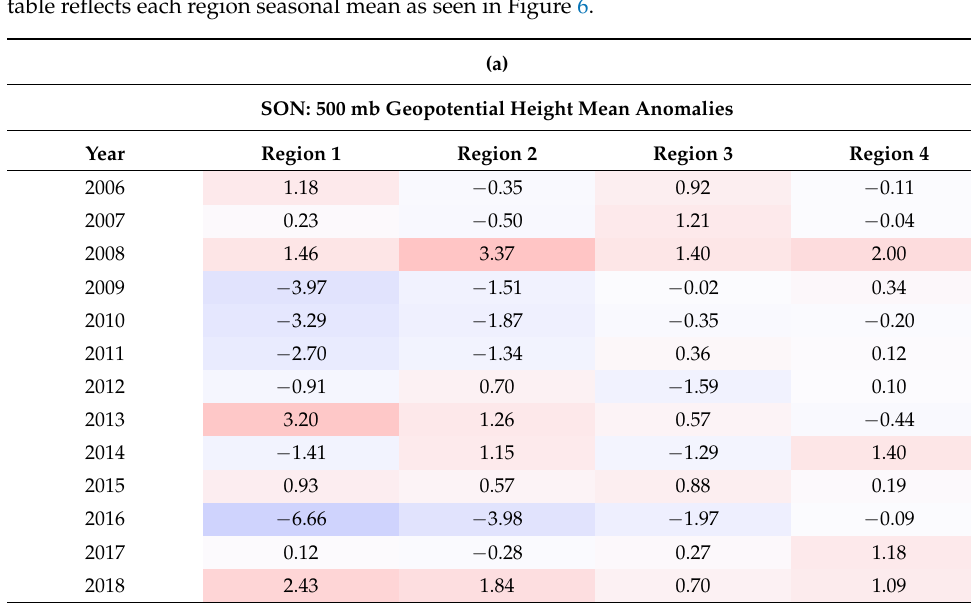
Figure 6. NCEP Reanalysis of 500 hPa geopotential heights and 1000–500 hPa anomalies from 2006 through 2019 for ( a ) September, October, November (SON), and ( b ) December, January, February (DJF). Table 1. 500 hPa geopotential height anomalies (decameter; dm) for ( a ) SON and ( b ) DJF, and 1000–500 hPa thickness anomalies for ( c ) SON and ( d ) DJF from 2006 through 2019. Color range in table reflects each region seasonal mean as seen in Figure